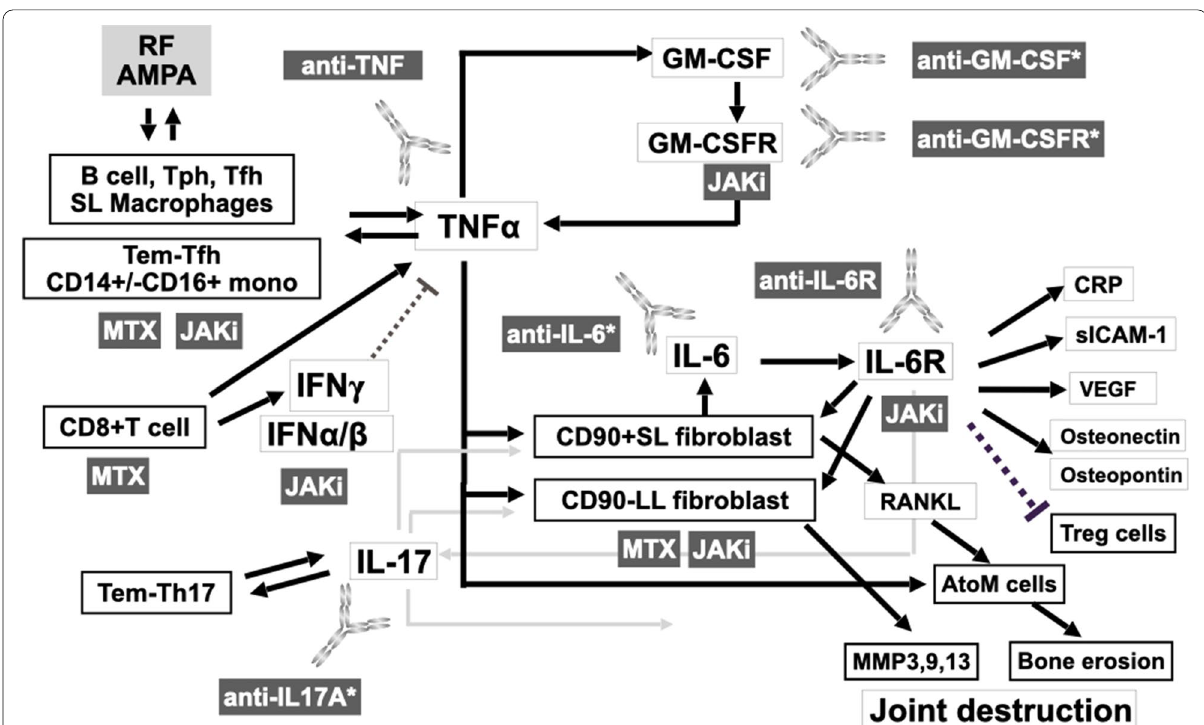
Fig. 3 Working hypothesis of the hierarchical cytokine network in patients with RA. White boxes indicate cells. Light gray box indicates autoantibody. Dark gray boxes indicate targeted treatments and methotrexate (MTX). RF, rheumatoid factor; AMPA, anti-modified protein antibody; SL, sublining in synovial tissues; LL, lining in synovial tissues. *Not approved in